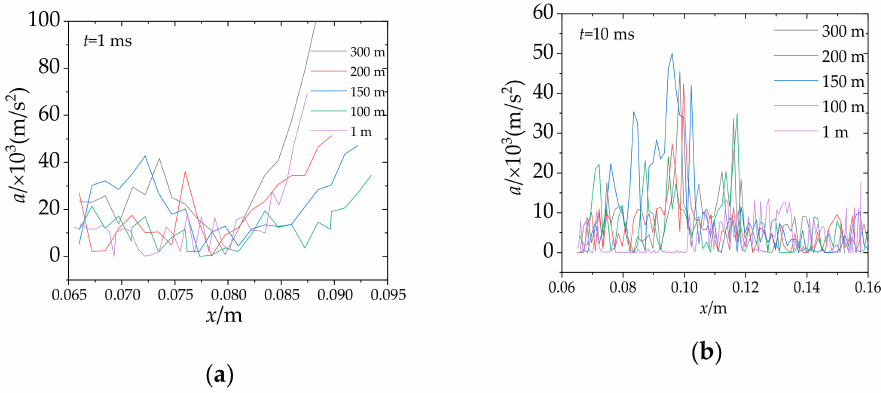
Figure 21. Interfacial acceleration ( a ) 1 ms ( b ) 10